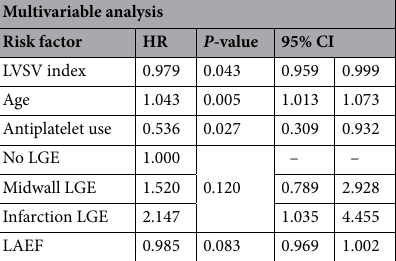
Multivariable analysis